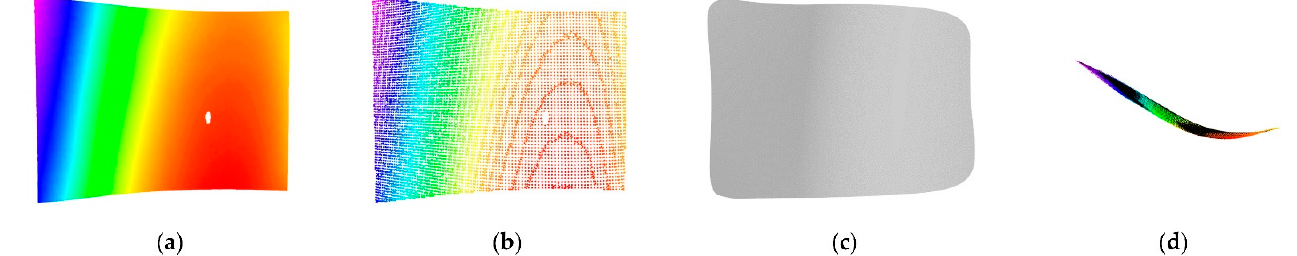
Figure 7. Surface reconstruction. ( a ) Dense point cloud of a rotor blade segment; ( b ) point cloud after down-sampling; ( c ) reconstructed surface (front view); ( d ) reconstructed surface (top view).